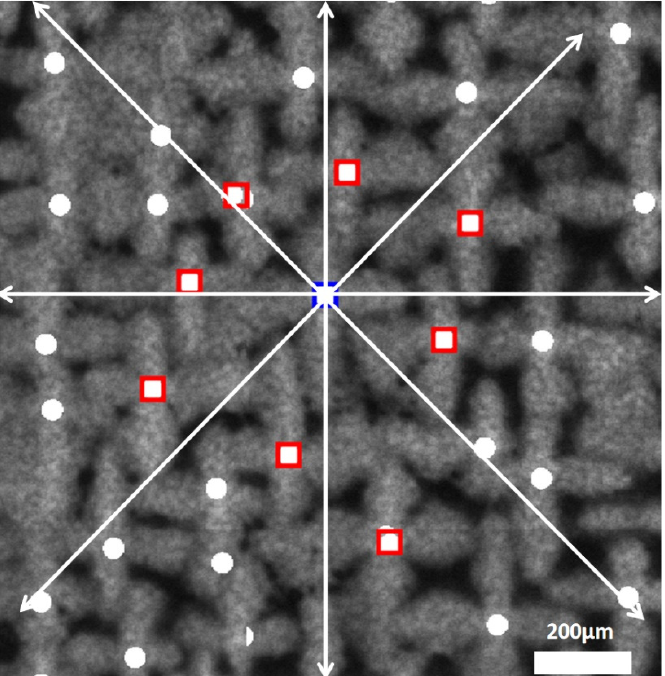
Figure 9. Example of interval division and the calculation result for local dendrite spacing: the blue box is the target dendrite core whose local dendrite spacing is to be calculated, and the red boxes are the positions of the dendrite cores closest to the target dendrite core in each interval. The Euclidean distance is defined as the dendrite spacing of the target dendrite core in this interval.